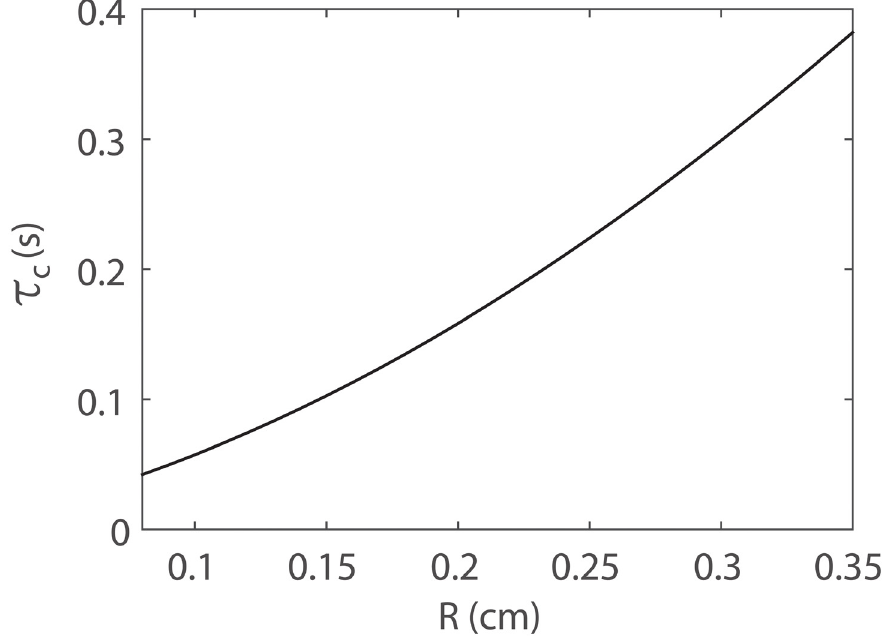
Fig 9. The characteristic time, τ c , of structured trees as a function of root vessel radius R . In the estimate of τ c using Eq (30), the length of the longest branch L is 10 times the length of the root vessel and c e is chosen to be the pulse wave speed of the root